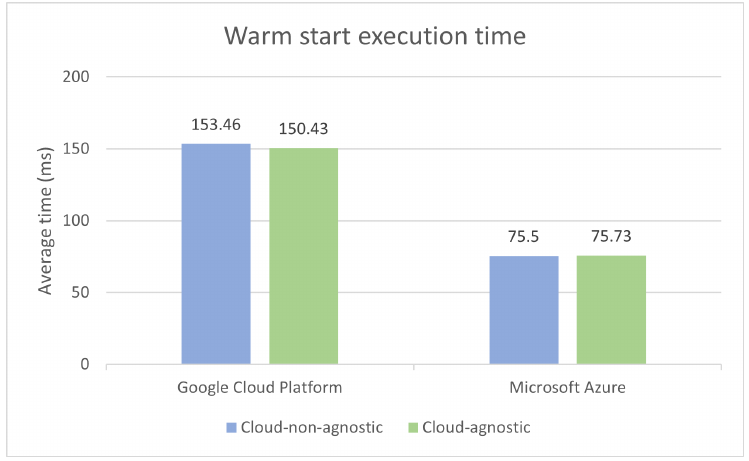
Figure 15. Warm start execution time.